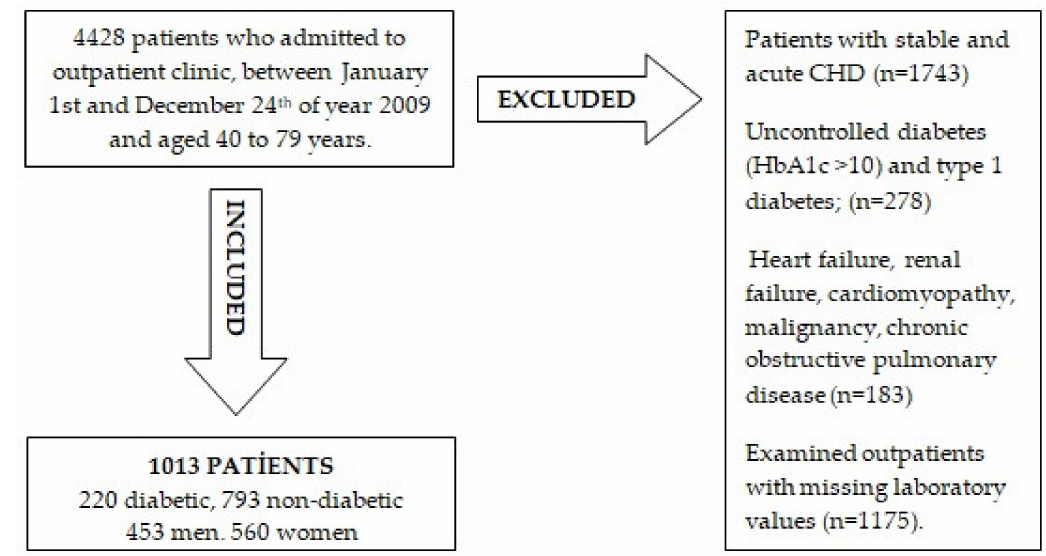
Figure 1. Flow diagram of the study (CHD: chronic heart